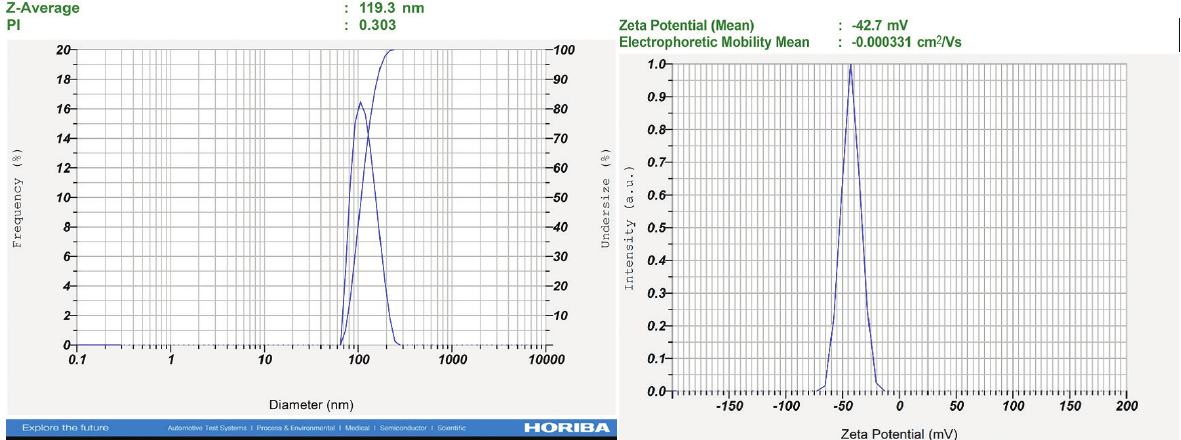
Figure 1 . Average size distribution and zeta potential of the best selected